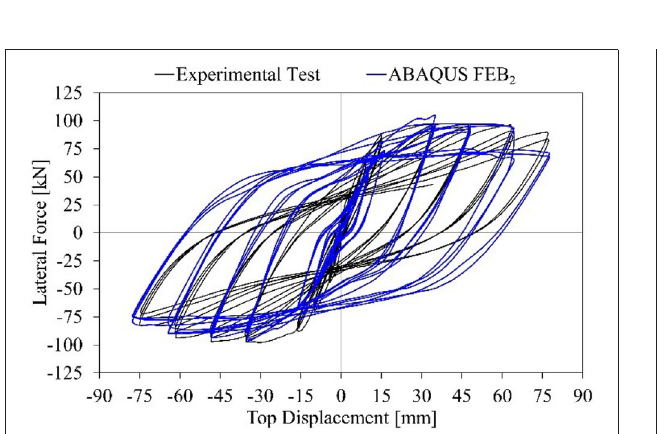
FIGURE 11 | Numerical simulation of DF adopting FEB 2 model.